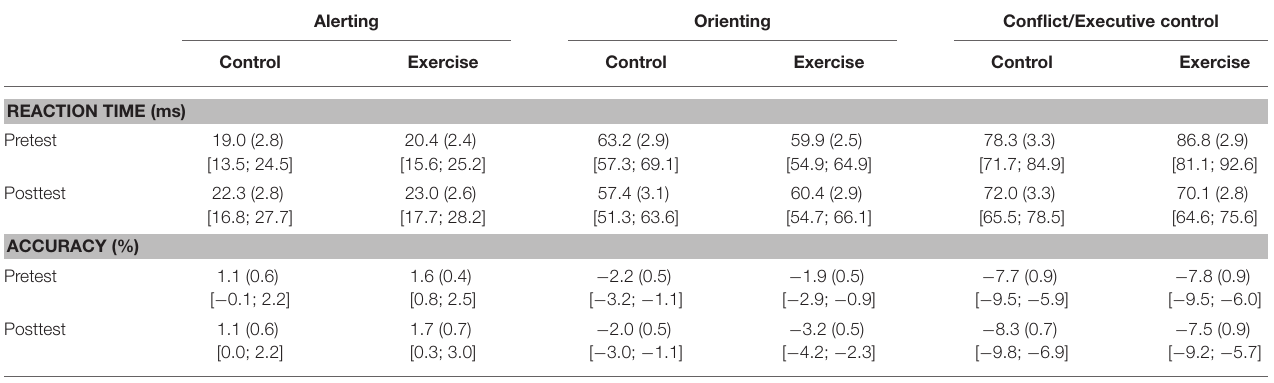
TABLE 3 | F-statistics of the RM ANOVA model for the ANT data (reaction time and accuracy). ANT